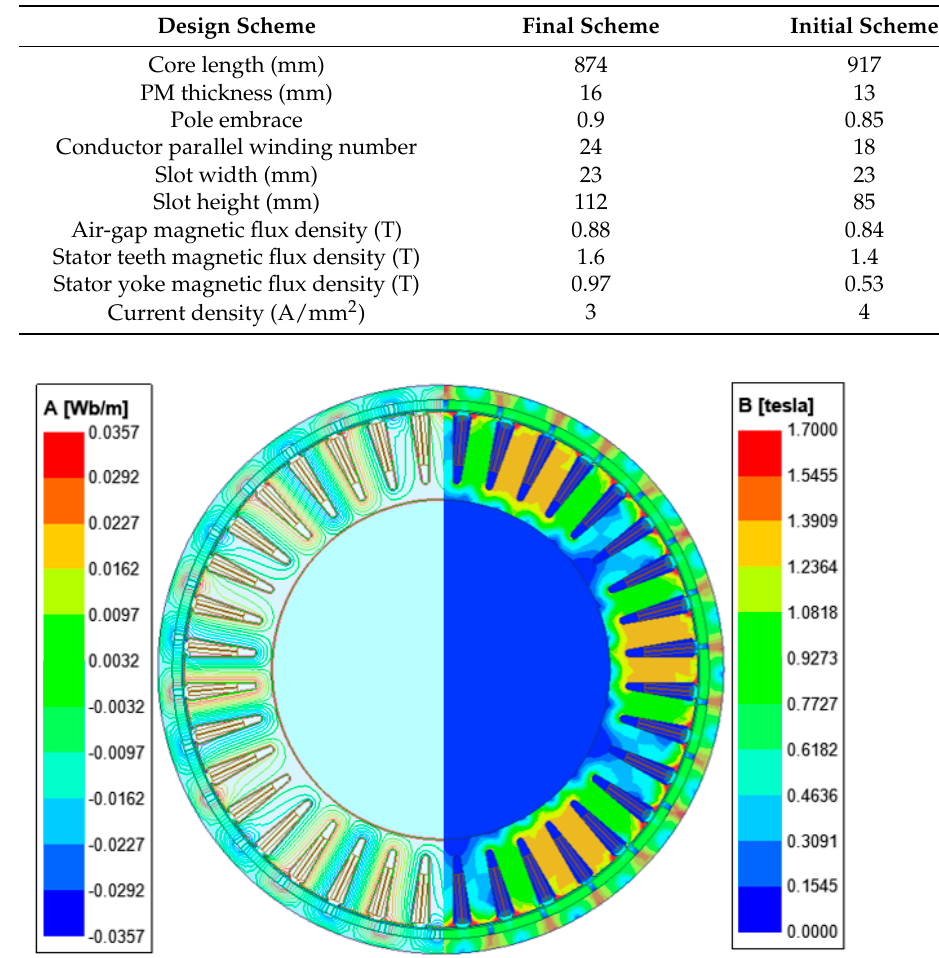
Table 3. The parameters comparisons of the final and initial schemes.